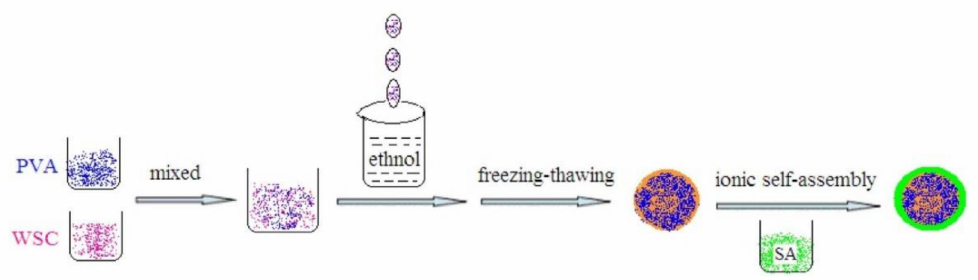
Figure 7. Formation of physically crosslinked dual-strengthened Ca-SA-WSC@WSC/PVA particles. Reprinted with permission from